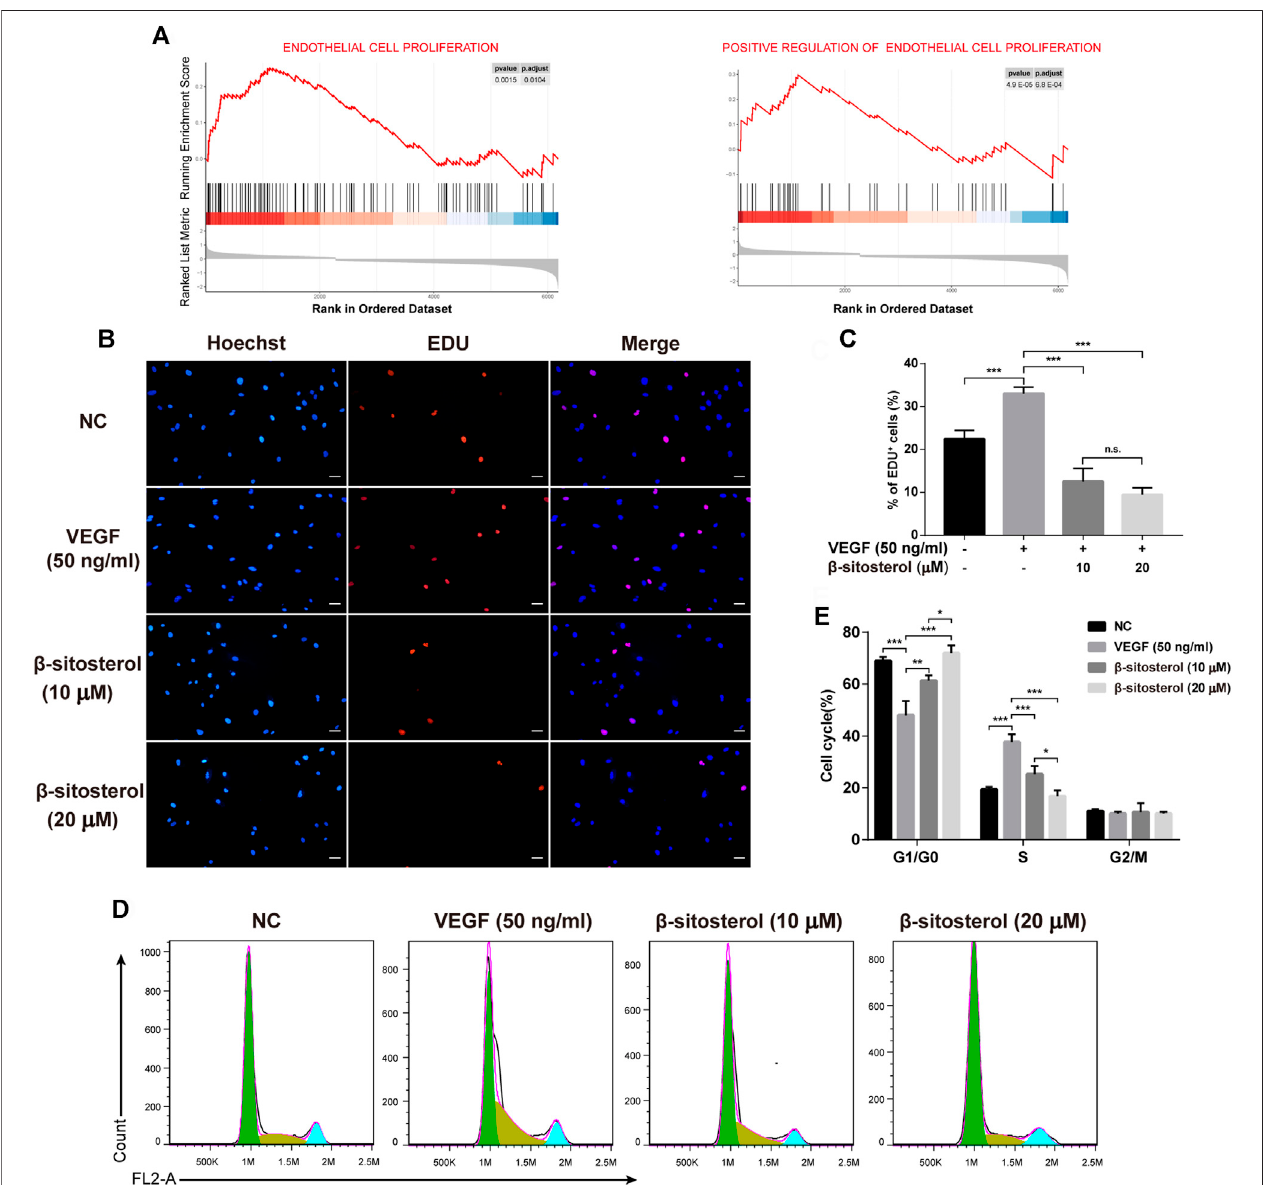
FIGURE2| InhibitoryeffectofBSSonHUVECs proliferationinducedbyVEGF. (A) GSEAanalysisofECsproliferationintheGSE121894 dataset. (B) Effect ofBSS on proliferation of HUVECs (VEGF 20 ng/ml for 24 h) and analysis of proliferation rate (C) by EdU (×200, scale bar = 50 μ m) ( n = 3). (D ) Effect of BSS on cell cycle of HUVECs and analysis of cell cycle data (E ) by fl ow cytometry ( n = 3). All data are shown as the mean ± SEM. * p < 0.05, ** p < 0.01, *** p < 0.001, n.s. = not signi fi cant.